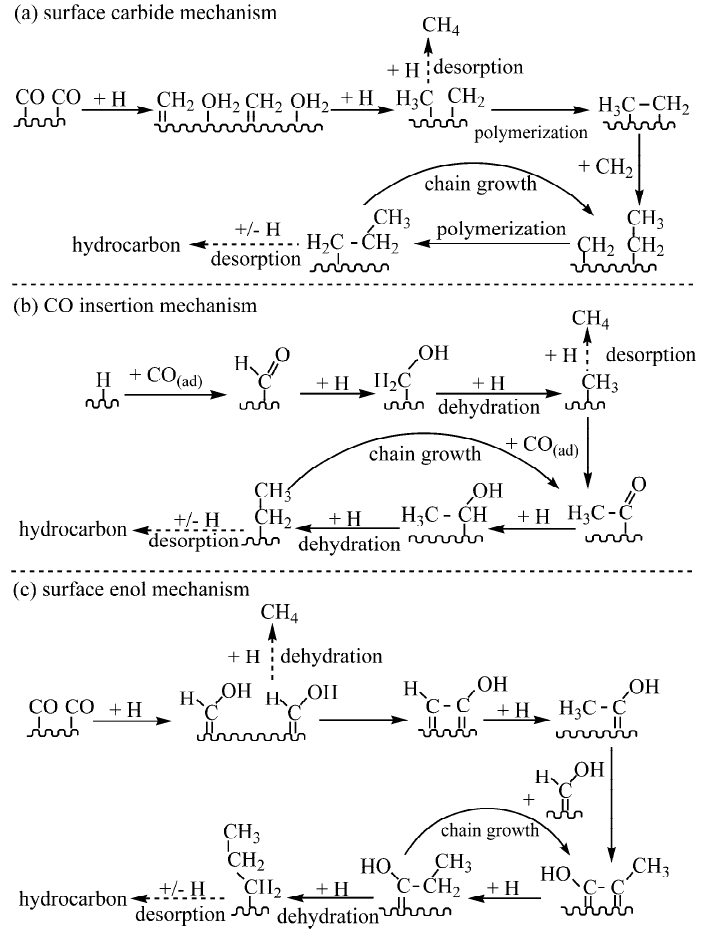
Scheme 1. The three prevalent chain growth mechanisms in FTS reaction. ( a ) surface carbide mechanism. ( b ) CO insertion mechanism. ( c ) surface enol mechanism. mechanism. ( b ) CO insertion mechanism. ( c ) surface enol